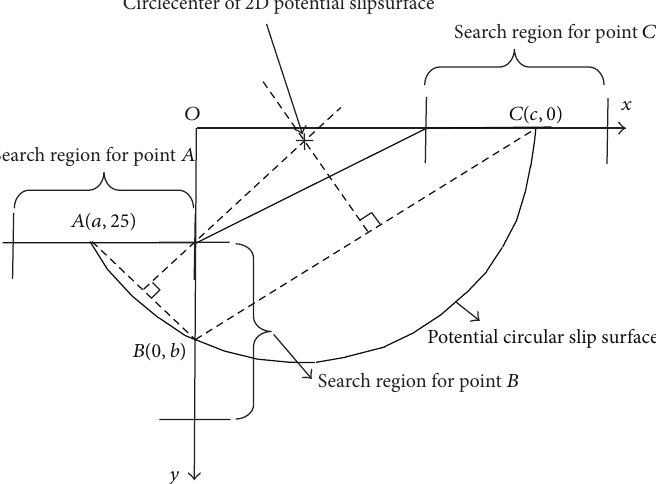
Figure 4: Potential failure circle center and radius determined and represented with points 𝐴 , 𝐵 , and 𝐶 .